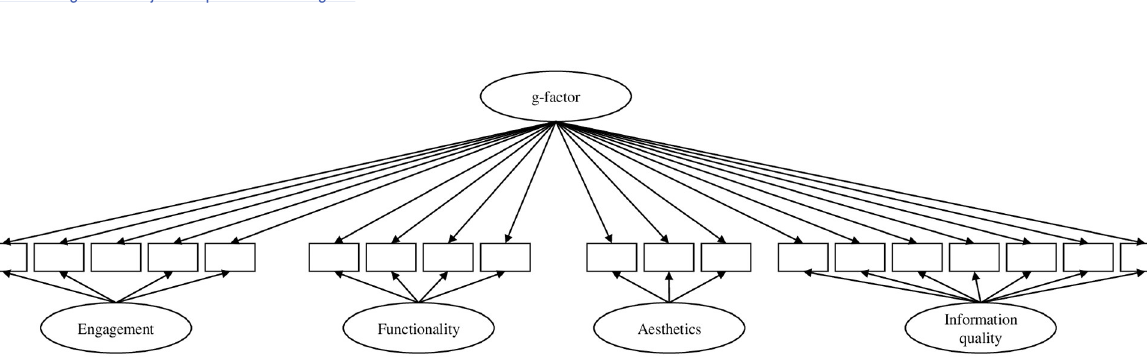
Fig 2. Hypothesized CFA model 2 of the MARS. Item-wise error variances are not represented in the models; correlations between errors were not allowed.